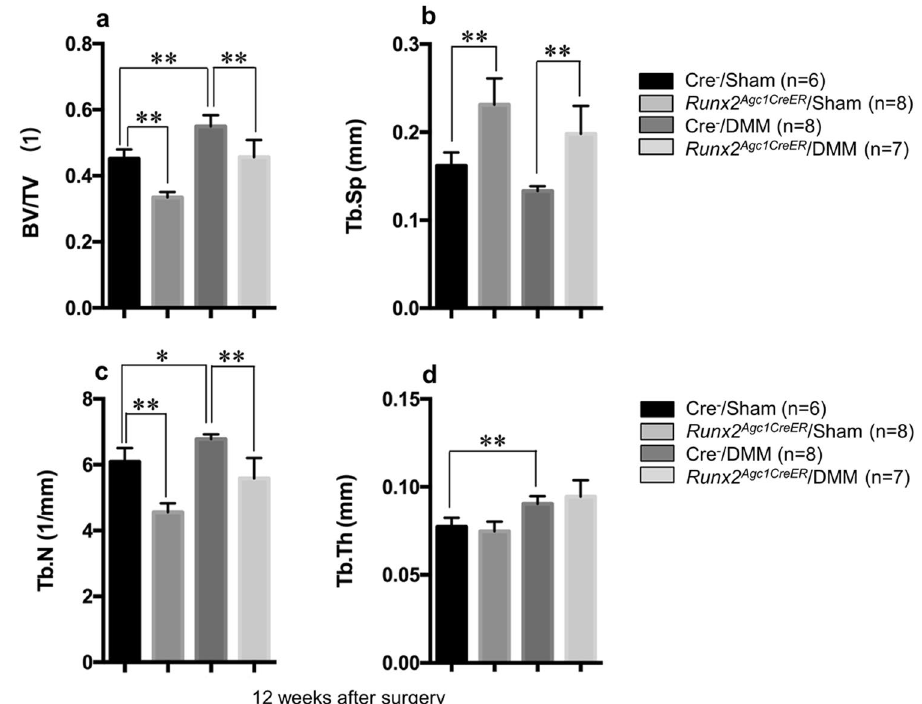
Figure 4. Micro-CT data display evidence of significantly increased bone mass of subchondral bone of knee joint in Cre negative mice with DMM surgery compared with Cre negative mice with sham surgery, and the increased bone mass was significantly reduced in Runx2 Agc1CreER KO mice. All the mice were administrated tamoxifen at 2-months of age, followed by the DMM surgery performed at 3-months of age. Mice were sacrificed 3 months after surgery. ( * P < 0.05, ** P < 0.01, one-way ANOVA followed by Tukey’s post-hoc test; n = 6–8 mice per